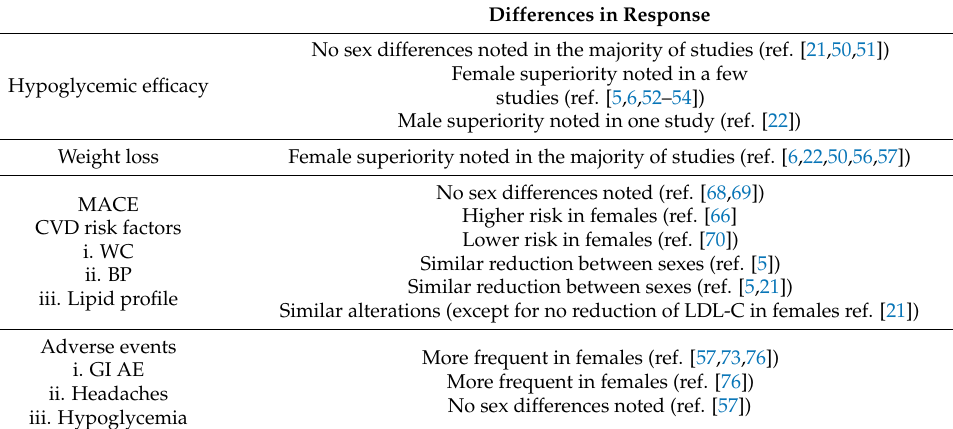
Table 3. Sex differences with respect to treatment with GLP-1 RAs. RAs: glucagon-like peptide 1 receptor agonists; CVD: cardiovascular disease; MACE: major adverse cardiovascular events; WC: waist circumference; BP: blood pressure; GI AE: gastrointestinal adverse events; LDL-C: low- density lipoprotein